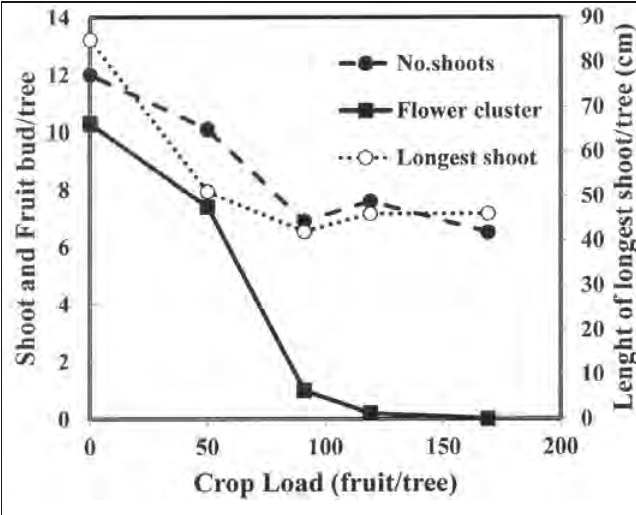
Fig. 17 - Effects of increasing fruit load of apple tree on shoot and fruit bud formation and on elongation of the longest shoot. (Ab-